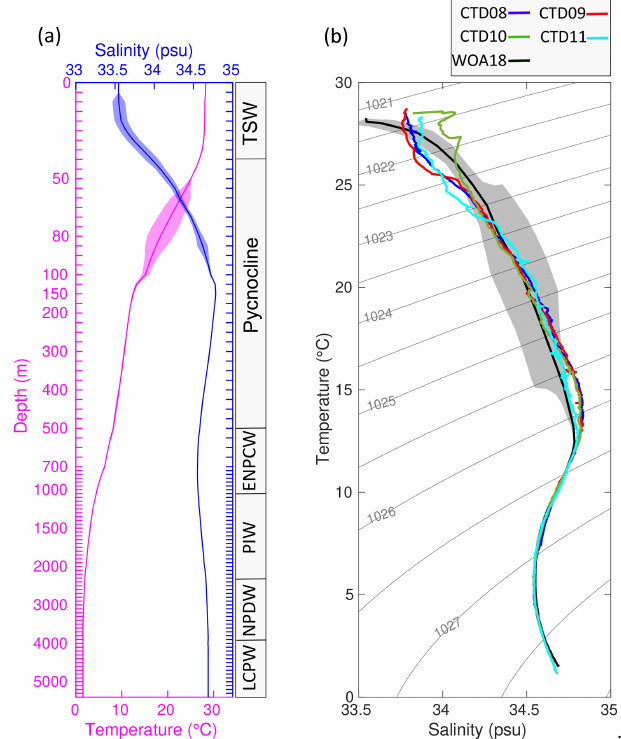
Figure 5. (a) Long-term climatology profiles of temperature and salinity obtained from WOA18 averaged over an area of 1 ◦ by 1 ◦ centered at the position of CTD08 (see Table 1). Standard devia- tion calculated from 13-year-long time series is shown as the shaded area in pink and blue for temperature and salinity. The vertical water mass distribution is shown on the right-hand side: Tropical Surface Water (TSW), Pycnocline Layer (Pycnocline), Eastern North Pa- cific Central Water (ENPCW), Pacific Intermediate Water (PIW), North Pacific Deep Water (NPDW), and Lower Circumpolar Water (LCPW). (b) T – S diagram determined from WOA18 climatology data and CTD data comparing the impact of eddy on seawater prop- erties. CTDs08, 09, and 10 are affected by the eddy, and CTD11 is shown as the reference station for comparison. Isopycnals are de- picted as grey lines with an interval of 0.5kgm − 3